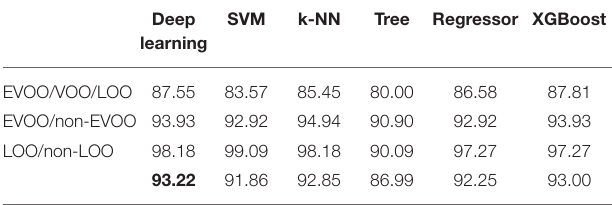
TABLE 5 | Specificity comparison with other methods for 2014–2016 (D1-D2)